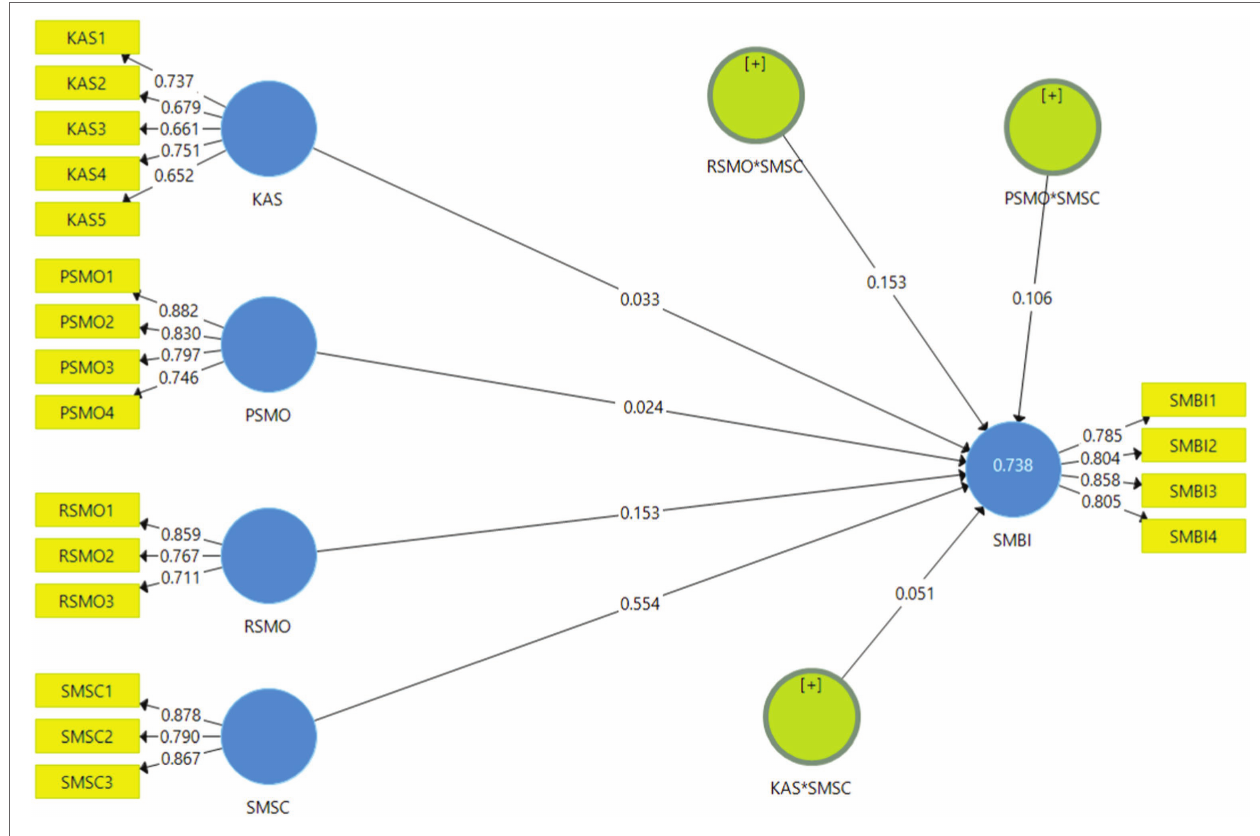
FIGURE 2 | Measurement